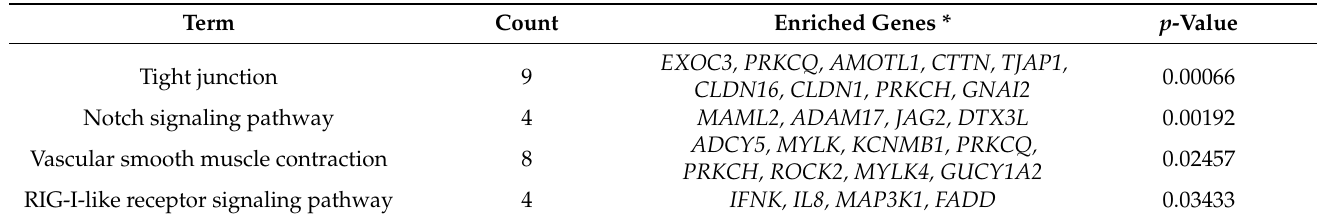
Figure 4. Enrichment analysis of switched compartmental genes (SCGs) in 5% switched A/B compartments between LDC and WCC liver cells. ( A ) GO enrichment analysis. The 30 most common GO terms are presented. ( B ) KEGG enrichment analysis. The 20 most common KEGG pathways are presented. The y -axis and x -axis indicate pathway name and rich factor, respectively. The size of the circle dot means gene number. Table 1. Enriched KEGG pathways of switched compartmental genes (SCGs) in 5% switched A/B compartments between LDC and WCC liver cells.